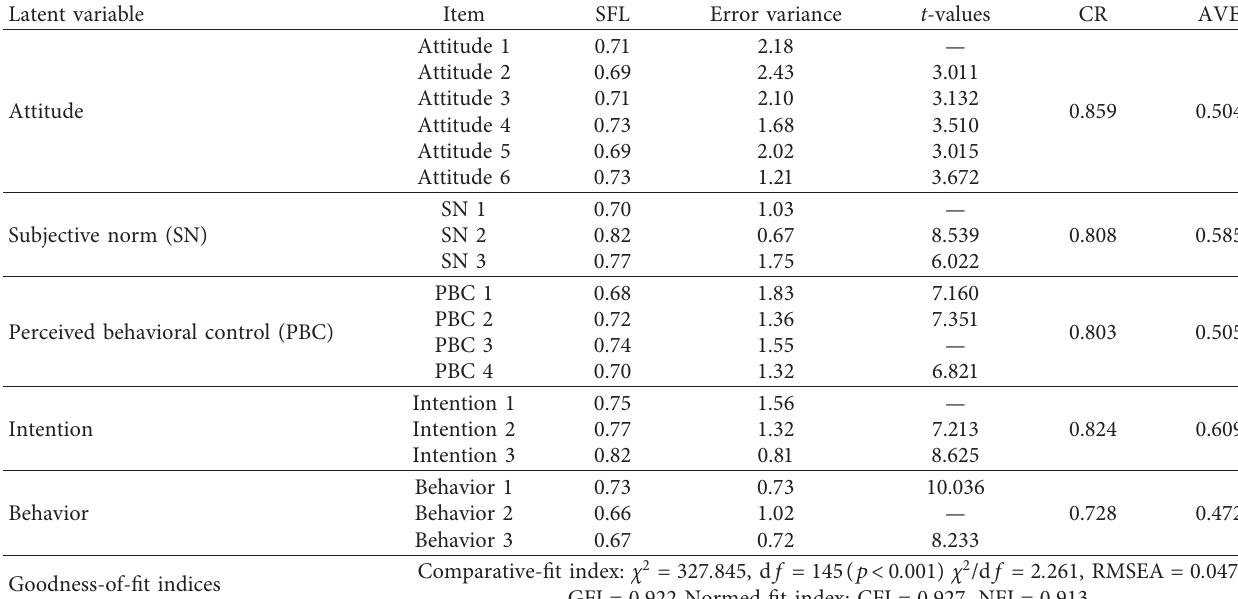
Table 3: Convergent validity of results.